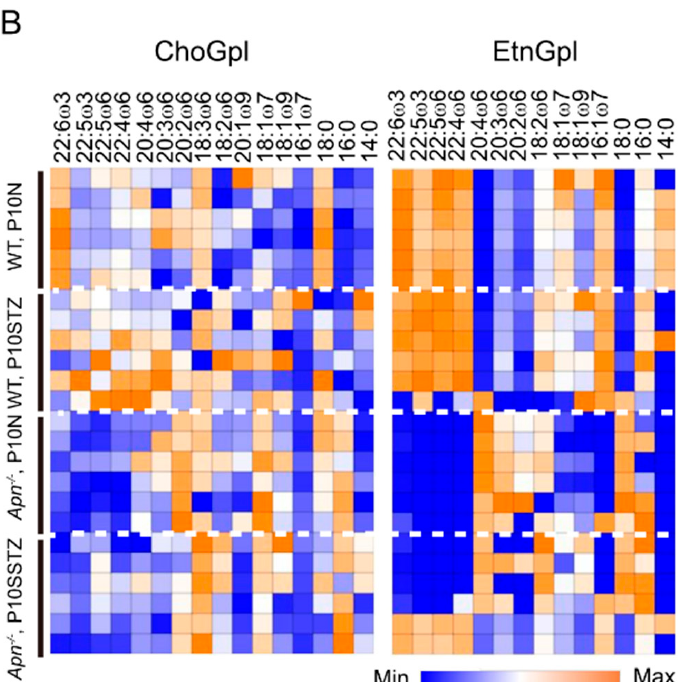
Figure 9. Loss of APN decreased unsaturated retinal lipid composition. Hyperglycemic induction in C57BL/6J (WT) and Apn − / − mice. An amount of 50 mg/kg STZ was i.p. injected daily from P1 to P9. At P10 the retinas were collected for lipidomic analysis. ( A ) Loss of APN caused reduced total fatty acids in ChoGpl and EtnGpl. ChoGpl, phosphatidylcholine; EtnGpl, phosphatidylethanolamine. 6–8 retinas were pooled as n = 1. n = 6 per group. ANOVA with Tukey’s multiple comparison test. * p < 0.05, ** p < 0.01. ( B ) In ChoGpl and EtnGpl, loss of APN decreased VLCPUFA ( ≥ 22C). 6–8 retinas were pooled as n = 1. n = 6 per group. Blue: minimum of levels; orange: maximum of levels. Heatmap was generated using ratio of change in percent mol (Morpheus, Broad Institute).